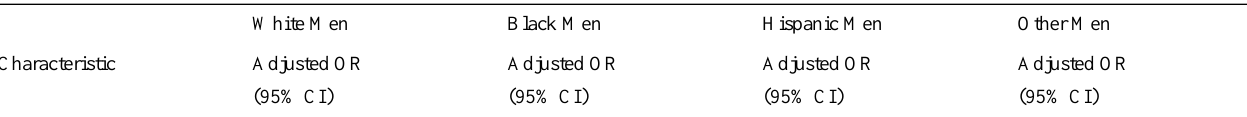
Table 2. Odds of clicking on study banner advertisements by MySpace.com users controlling for self-reported education, sexual identity, and race of model in advertisements and stratified by race of the MySpace.com user in the United States in